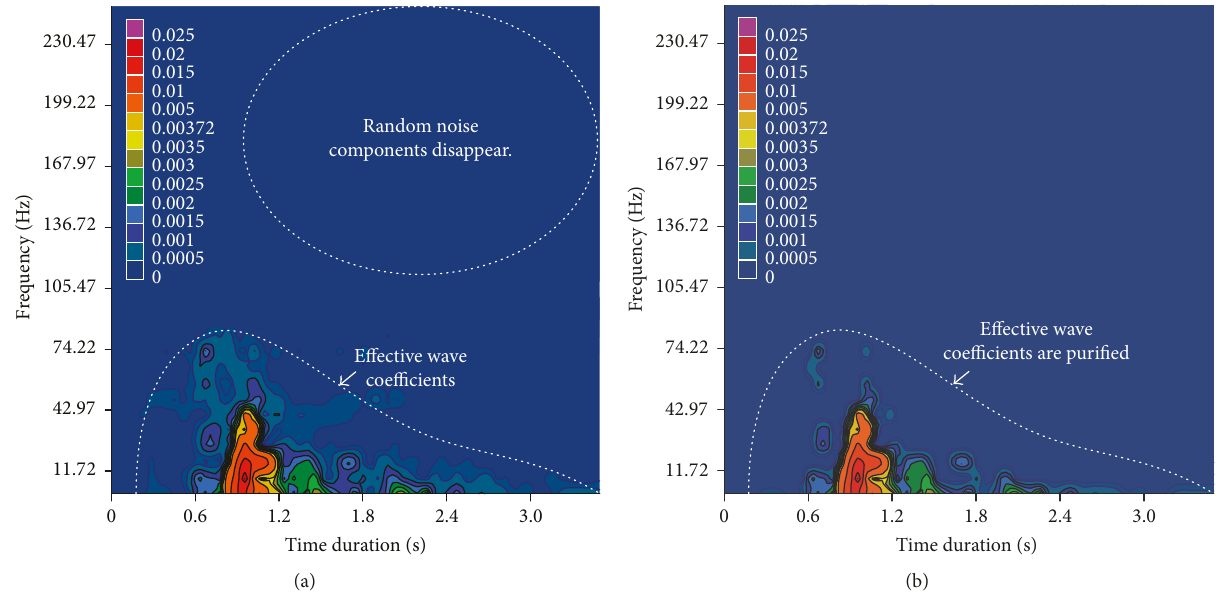
Figure 13: Identification results of the effective microseismic wave component after the preliminary extraction via the threshold frequency and advanced extraction via the threshold